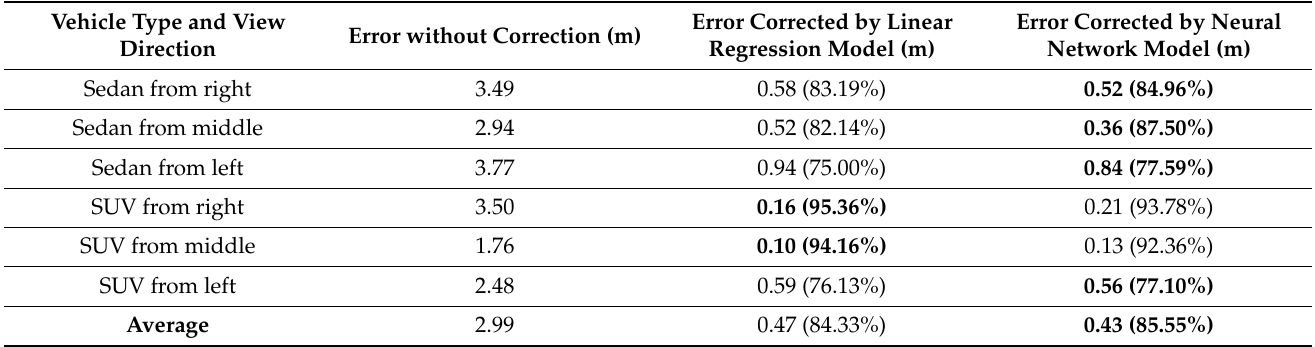
Table 1. Comparison of vehicle center error corrections by linear and nonlinear regression models (be tt er results shown in bold).